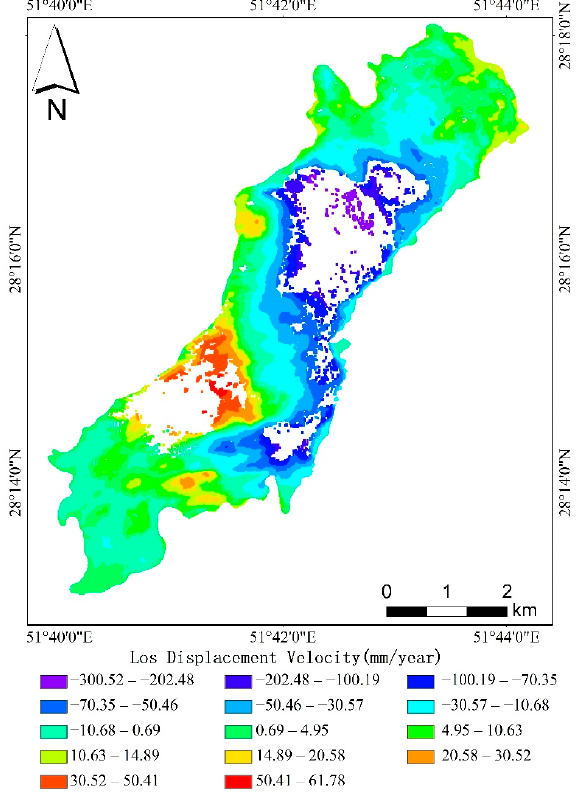
Figure 7. The average velocity of surface deformation in Kuh-e-Namak (Dashti) namakier. In total, 4000 points on the flank and dome of the namakier were randomly selected to explore the relationship between the deformation of the namakier and weather condi- tions. Then, because weather condition is one of many factors that affect deformation of namakier, gray relational analysis [51] was utilized to calculate the grey relational degree between the absolute value of the time series displacement of these points, the accumu- lated precipitation, and the average temperature (Table 6). Table 6. The average grey relational degree between the absolute value of the time series displace- ment, average temperature, and accumulated precipitation during the Sentinel-1A image acquisi- tion time interval. Number of Points